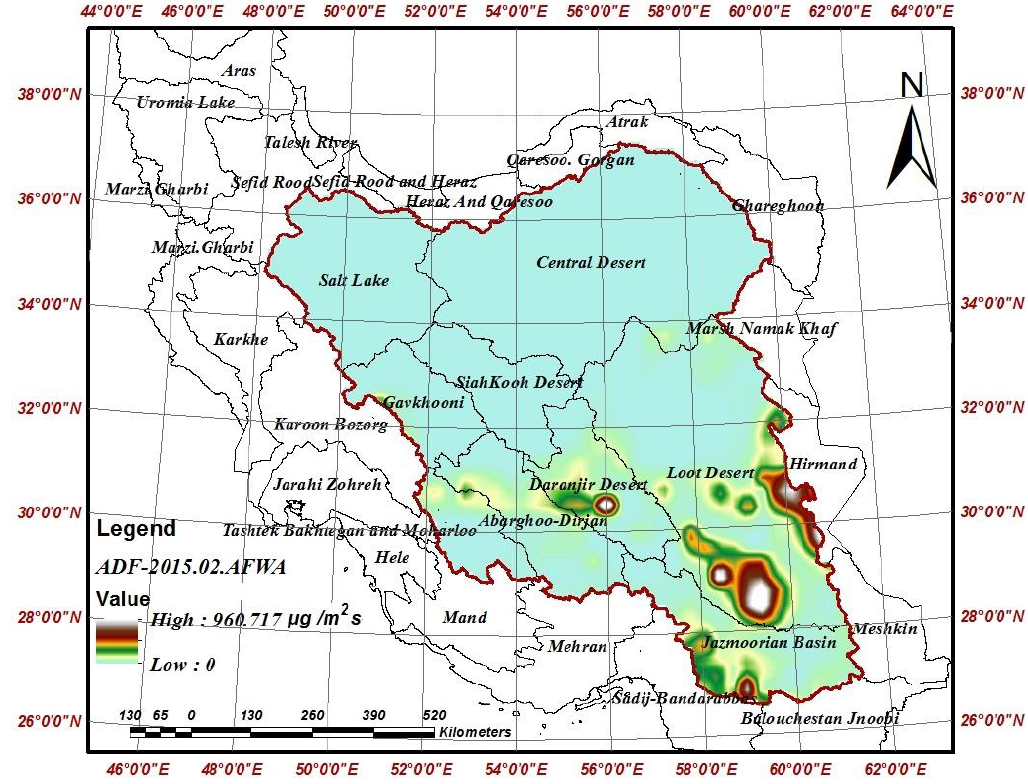
Figure 11. Mean Spatial Pattern of Storm Dust Flux (µg/m 2 s) on 21 February 2015 with AFWA Scheme.